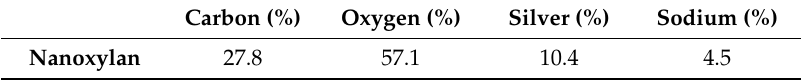
Table 2. Energy dispersive X-Ray spectroscopy elemental composition of